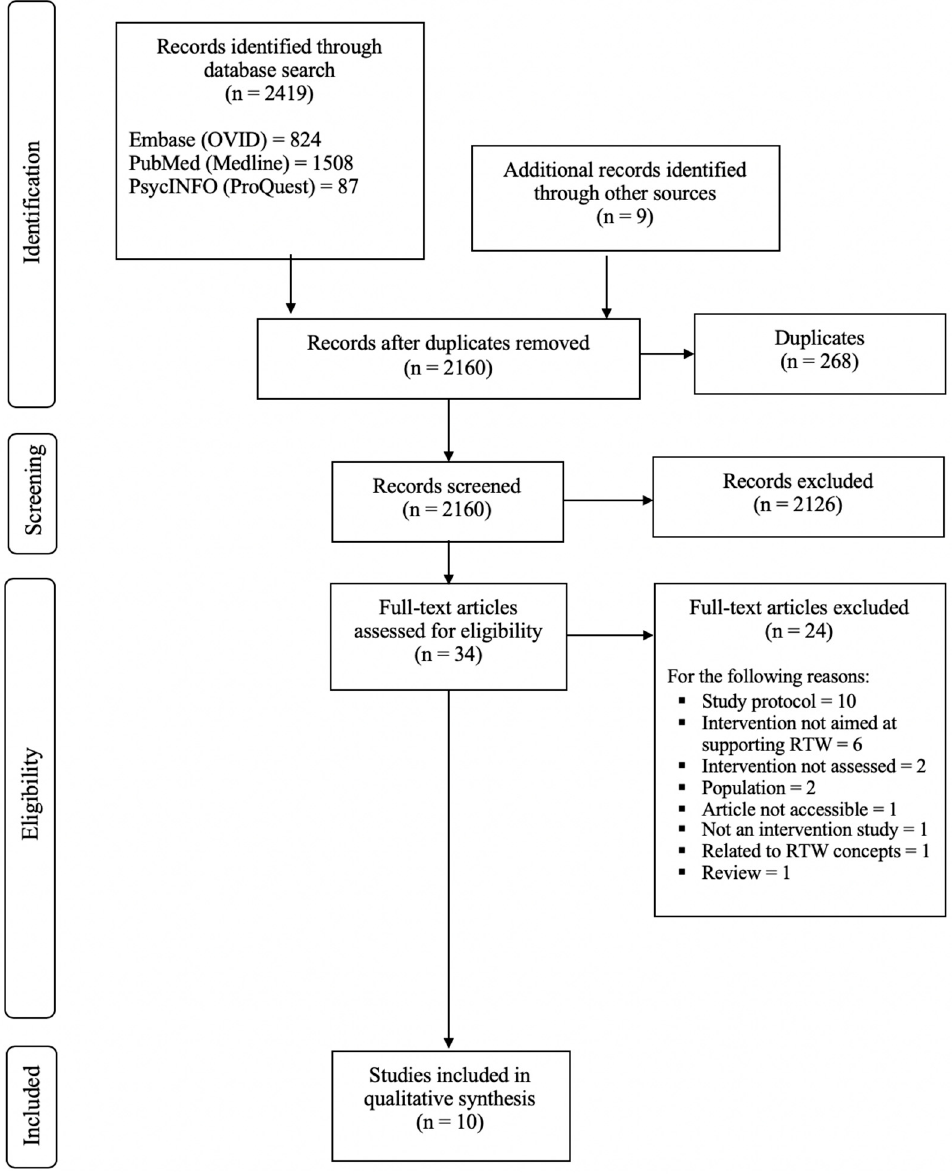
Figure 1. Flow diagram of study selection according to PRISMA.